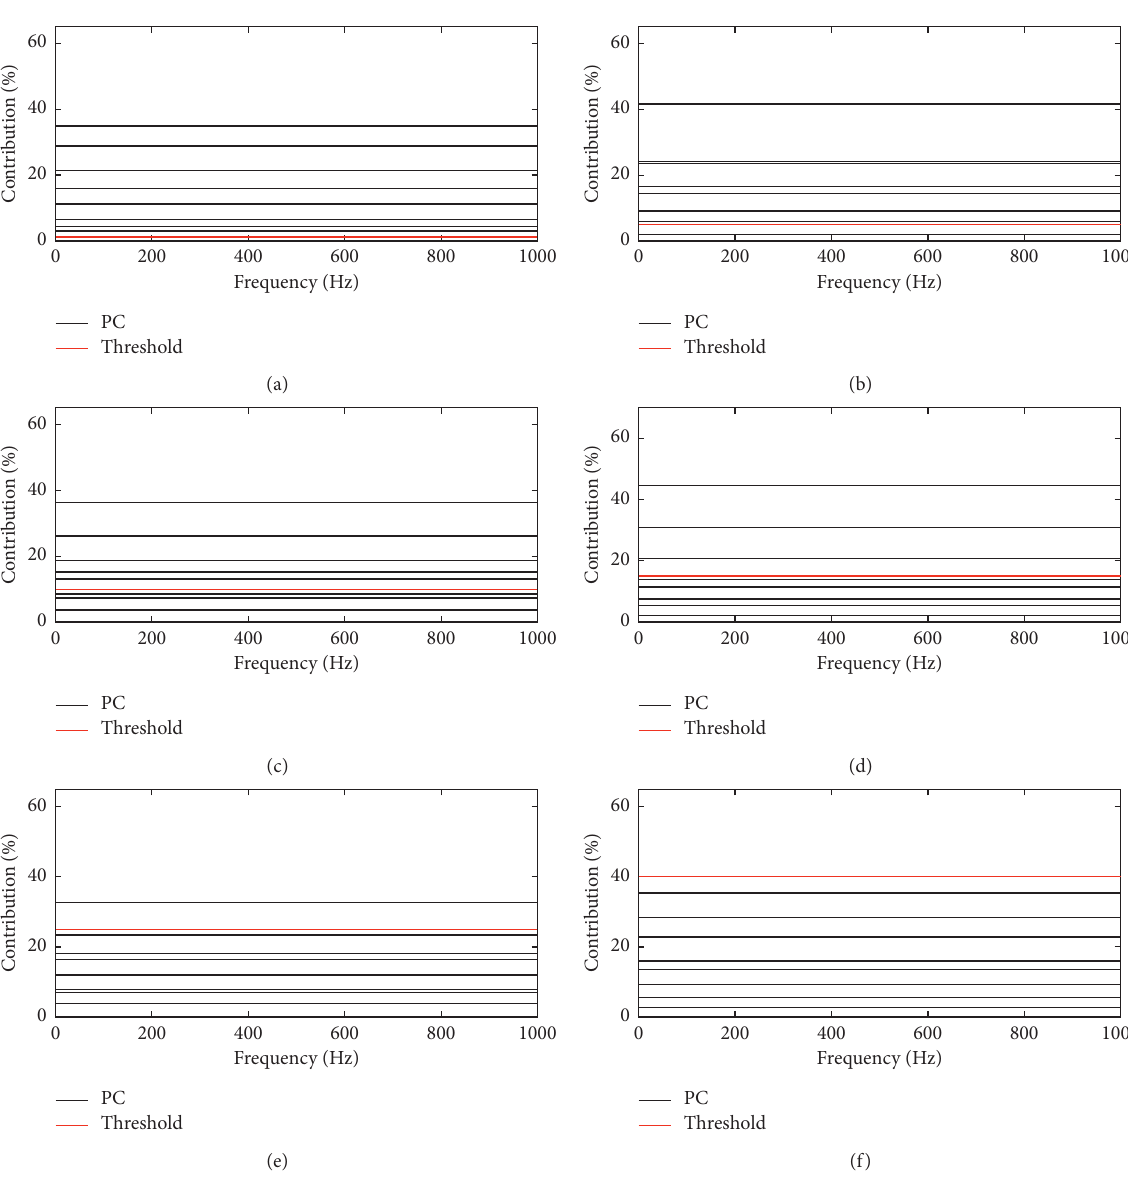
Figure 5: Number of relevant PCs according to the threshold value. Principle component contribution: (a) c � 1%; (b) c � 5%; (c) c � 10%; (d) c � 15%; (e) c � 25%; (f) c �